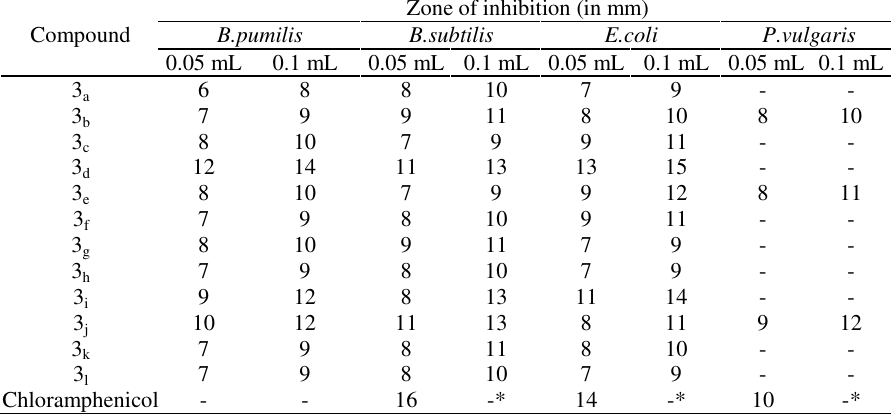
Table 1. Antibacterial activity of chalcone derivates Zone of inhibition (in